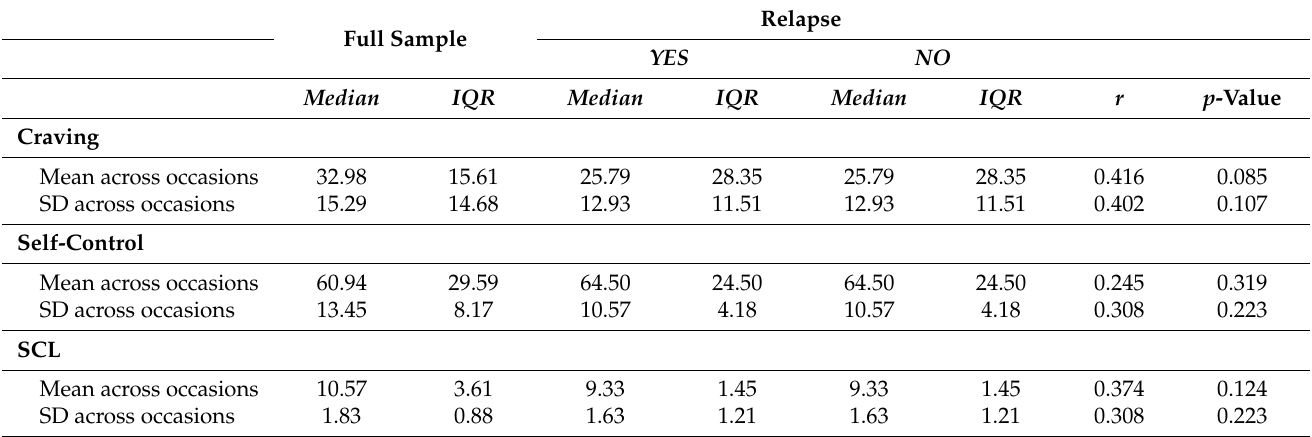
Table 2. The group level statistics for repeated measures. SCL: Hopkins Symptom Check List—5 item version. The mean and SD are across sessions for each participant. Median and IQR of Mean and SD are across participants. The Wilcoxon–Mann–Whitney test for between group differences for relapse. Effect sizes (r) are reported as absolute